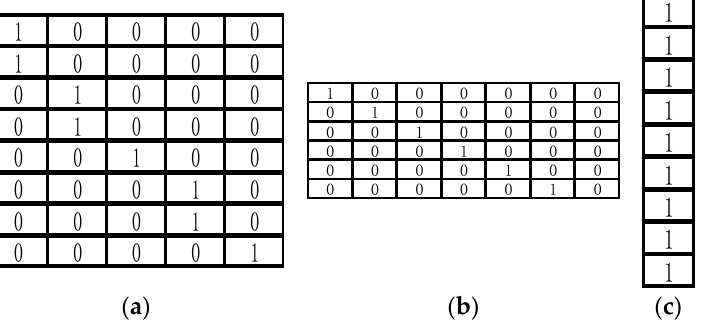
Figure 11. The template design of three dominant wind directions of a winter corridor with the length = 9: ( a ) − 67.5 degree template; ( b ) − 45 degree template; ( c ) − 90 degree template.